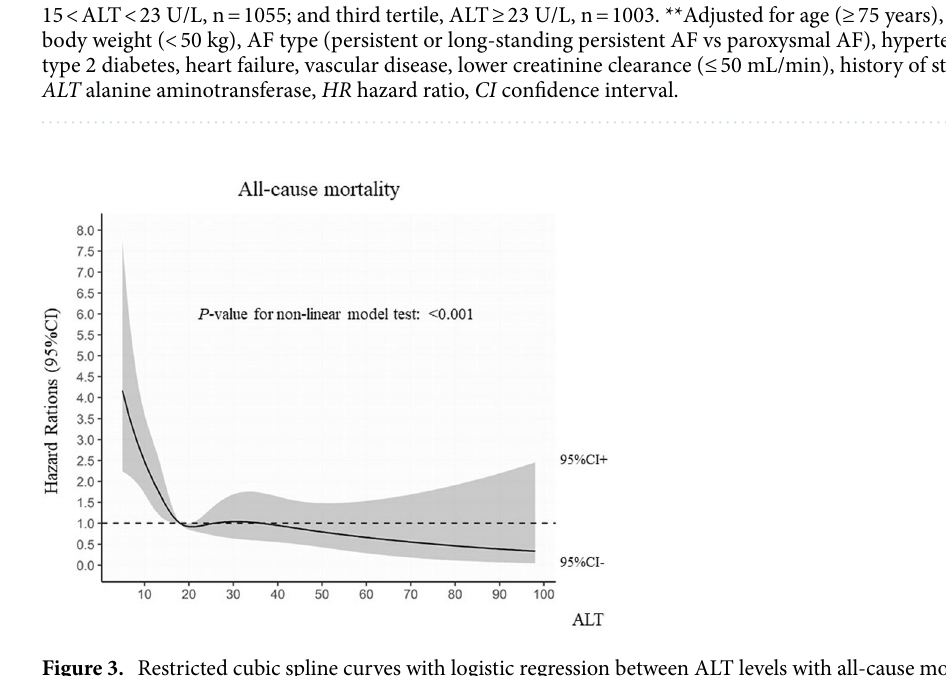
Figure 3. Restricted cubic spline curves with logistic regression between ALT levels with all-cause mortality. Black dashed horizontal lines represent the odds ratio of 1.0. Black lines indicate the estimated hazard ratio, and the shaded ribbons represent a 95% confidence interval